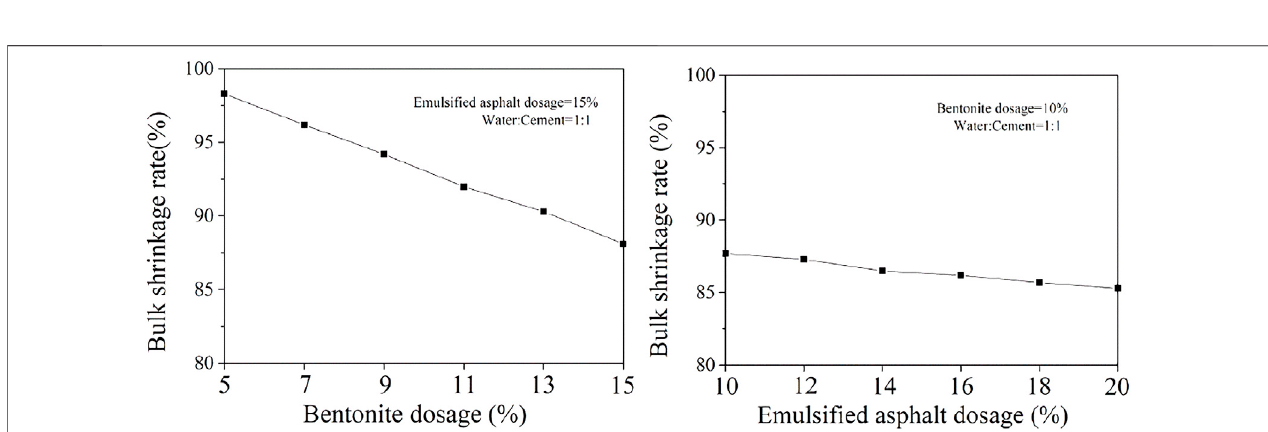
Frontiers in Earth Science |